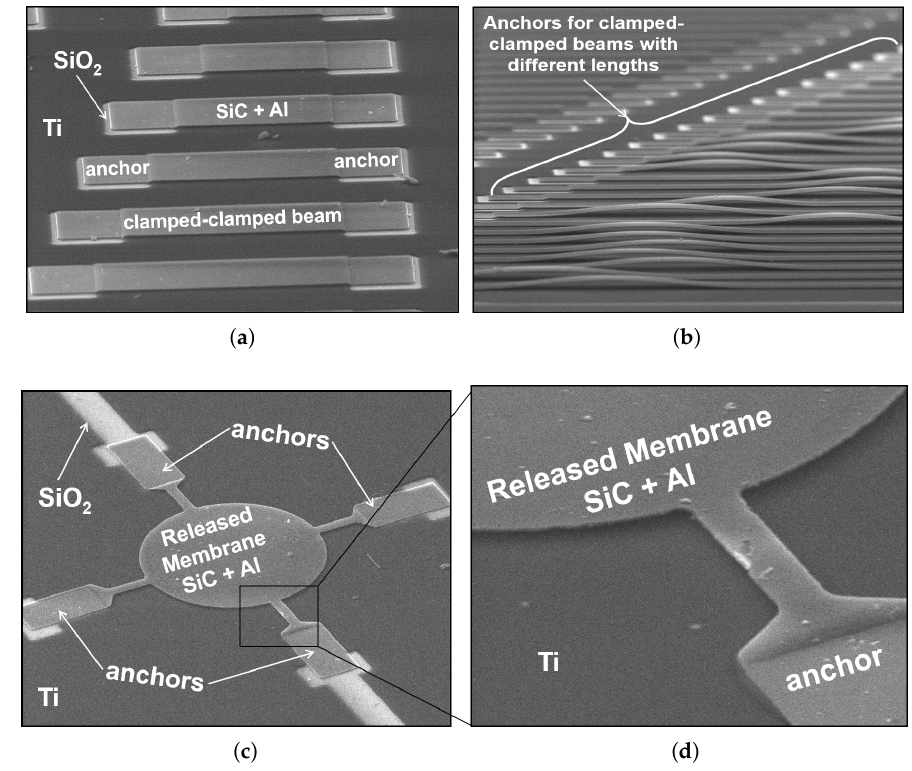
Figure 3. SEM images of fabricated released test structures using the complete process flow: ( a ) top view of clamped–clamped beams; ( b ) side-view of clamped-clamped beams suffering residual compressive stress; ( c ) circular membrane suspended by four beams; ( d ) close-up of one of the